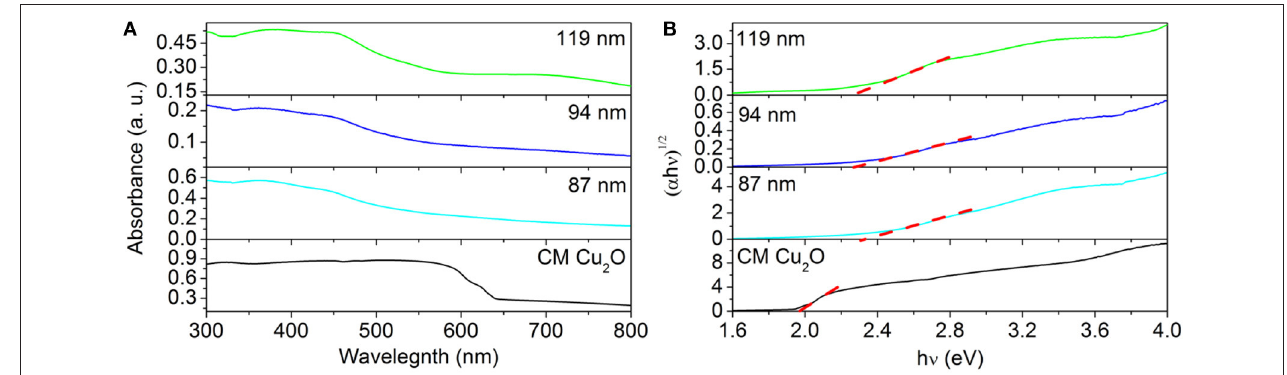
FIGURE 8 | (A) Ultraviolet–visible spectroscopy extinction spectra of Au@Cu x O core–shell MPNSs with different diameters and UV-vis diffuse-reflectance spectra of commercial Cu